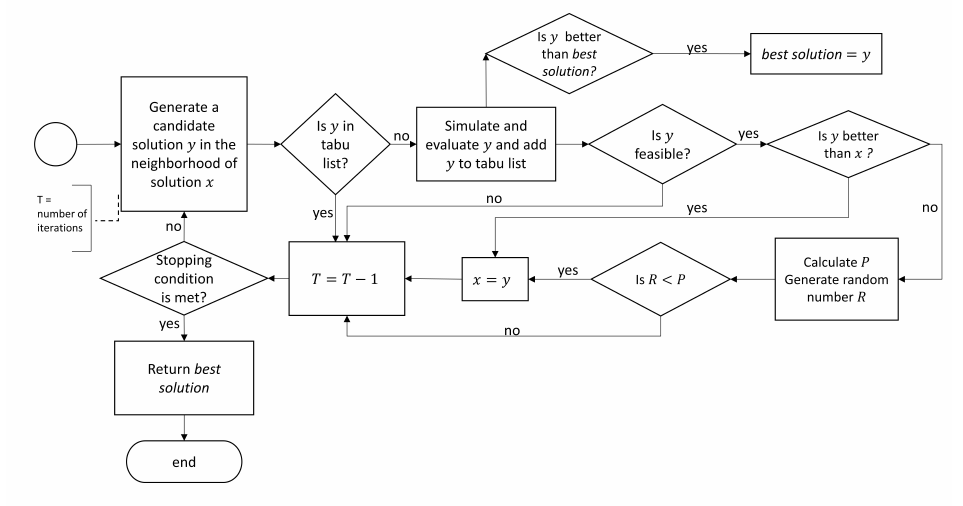
Figure 5. Flow diagram of the Hybrid metaheuristic algorithm.